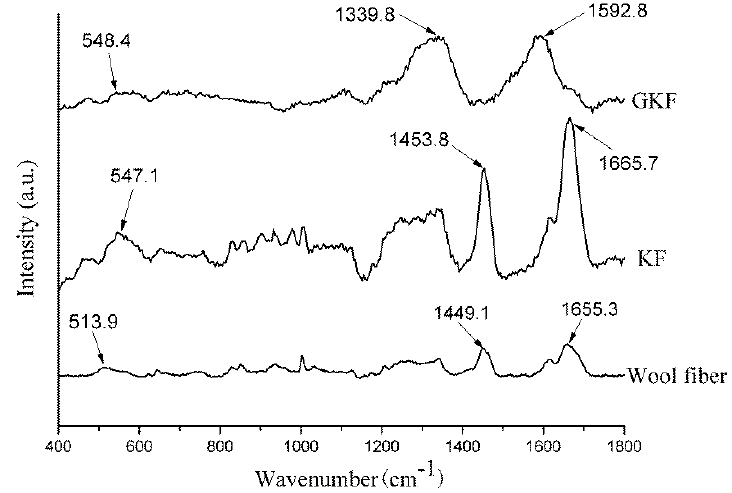
Table 1. Raman characteristic peak distribution of the test samples (cm −1 ).